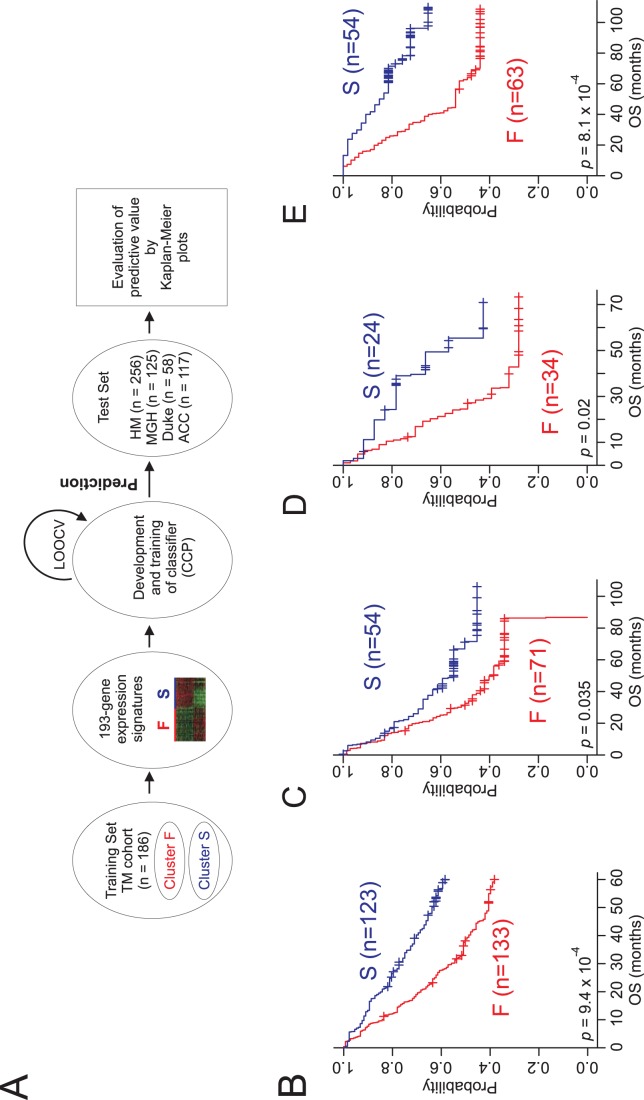
Construction of the prediction model and evaluation of predicted outcome.(A) Schematic overview of the strategy used for constructing prediction models and evaluating the predicted outcomes based on gene expression signatures. Kaplan-Meier plots of the overall survival (OS) of the 2predicted groups of lung adenocarcinoma patients in the (B) HM, (C) MGH, (D) Duke, (E) and ACC cohorts. The differences between groups were significant, as indicated by the log-rank test. The + symbols in panels B–E indicate censored data.